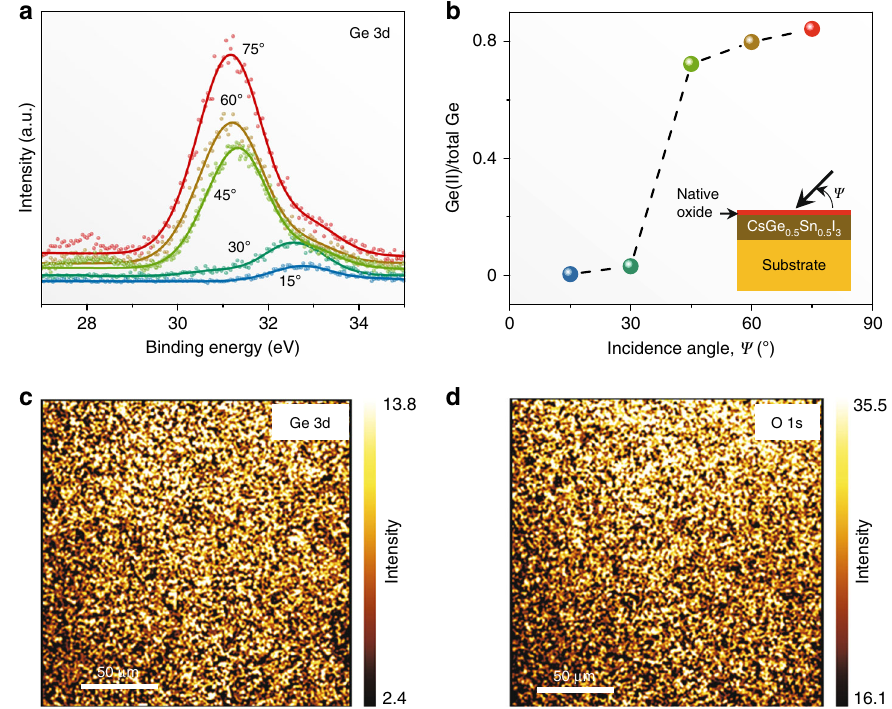
Fig. 2 XPS characterization. a Ge 3d XPS spectra, at different incidence angles, from CsSn 0.5 Ge 0.5 I 3 perovskite thin fi lm that has been exposed to air. b Corresponding plot of the fraction of Ge(II) vs. the incidence angle. c , d XPS maps of Ge 3d (33 eV) and O 1s (532 eV), respectively, from the same area of the thin fi lm